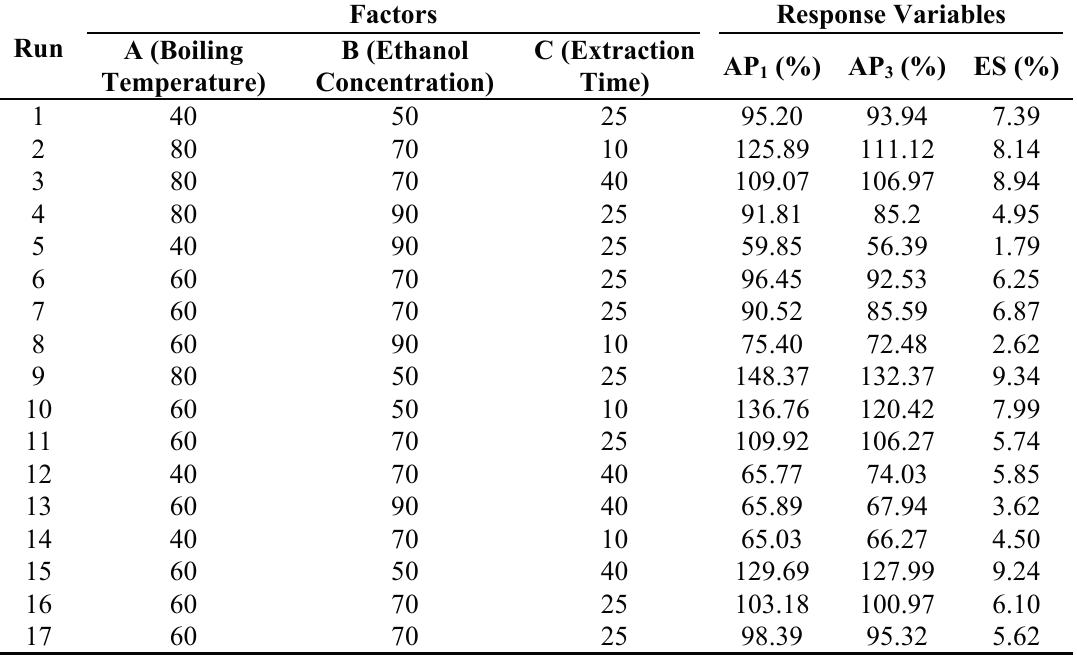
Table 3. Arrangement and results of the Box-Behnken design.